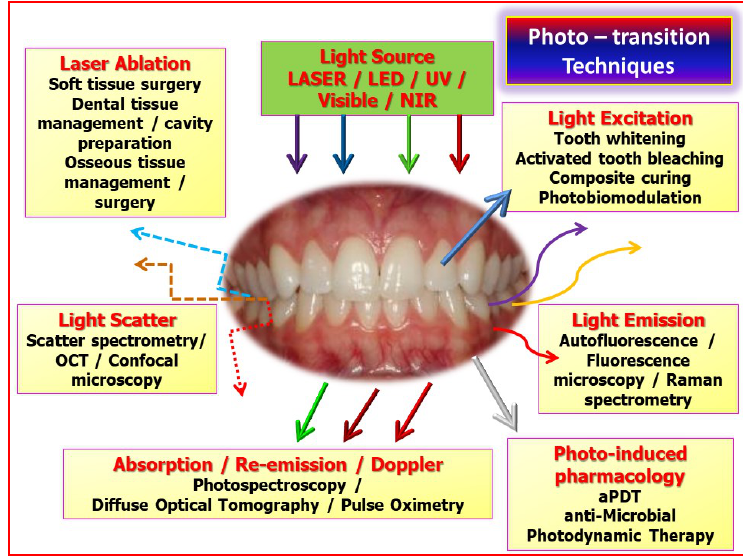
Figure 1. An overview of the manipulation of incident photonic energy, such as laser light as an adjunct to screening, diagnostic and therapeutic clinical activity. Key: LED—light emitting diode, UV—ultra-violet, NIR—near infra-red, with multi-wavelength representation as vertical incident arrows. OCT—optical coherence tomography, aPDT—antimicrobial photodynamic therapy. Re-emission, as direct beam or scattered irradiance is represented by complete and dotted arrows, either straight or non-linear. Dent. J. 2019 , 7 , x FOR PEER REVIEW